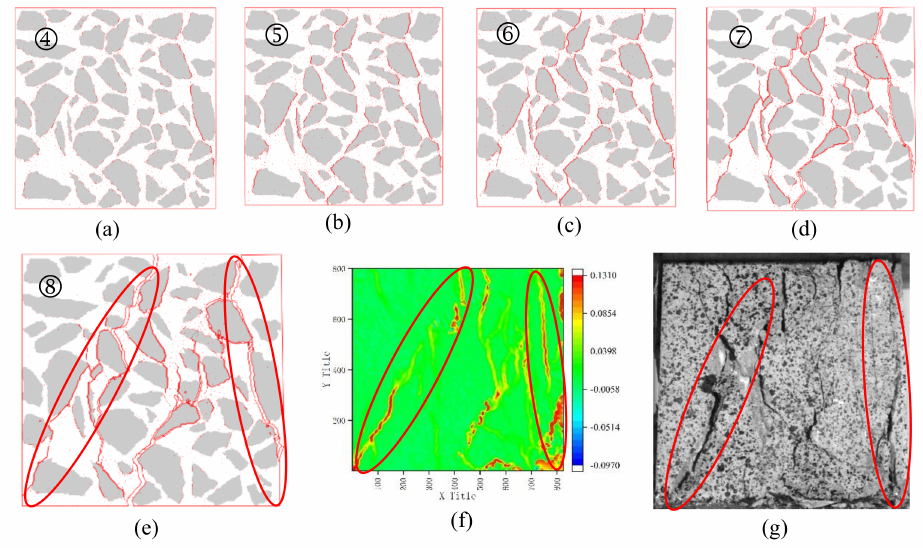
Figure 10. The cracks development process of NC01 and final cracks distribution of RealNC01: ( a ) The initial cracks appeared in ITZs; ( b ) Forming crack zone surround aggregates; ( c ) Cracks appeared in CIEs; ( d ) Forming the shear bands; ( e ) Final cracks distribution of NC01; ( f ) Final cracks distribution in contour of RealNC01; ( g ) Final cracks distribution of RealNC01; (cid:195) – (cid:199) corresponding to the point in Figure